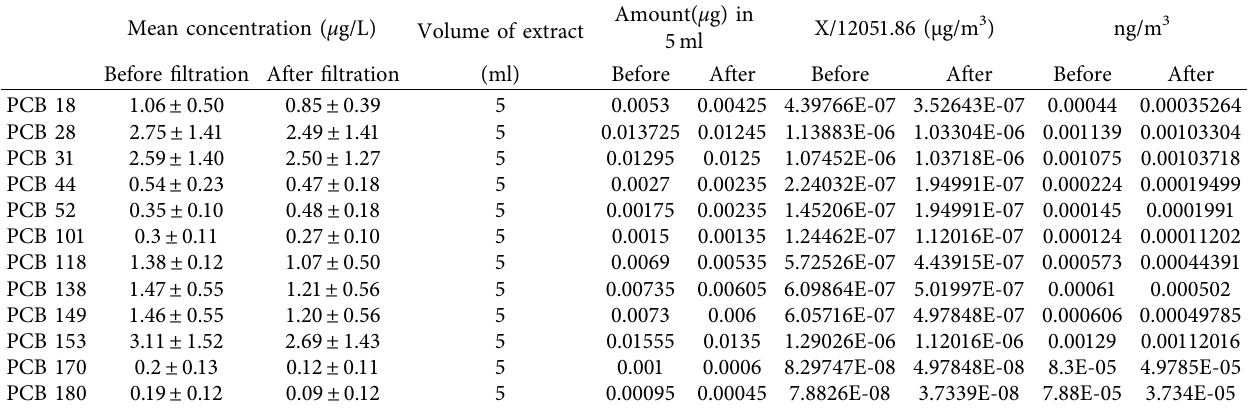
Table 6: Indicator PCB concentrations in the chimney (in ng/m 3 ).